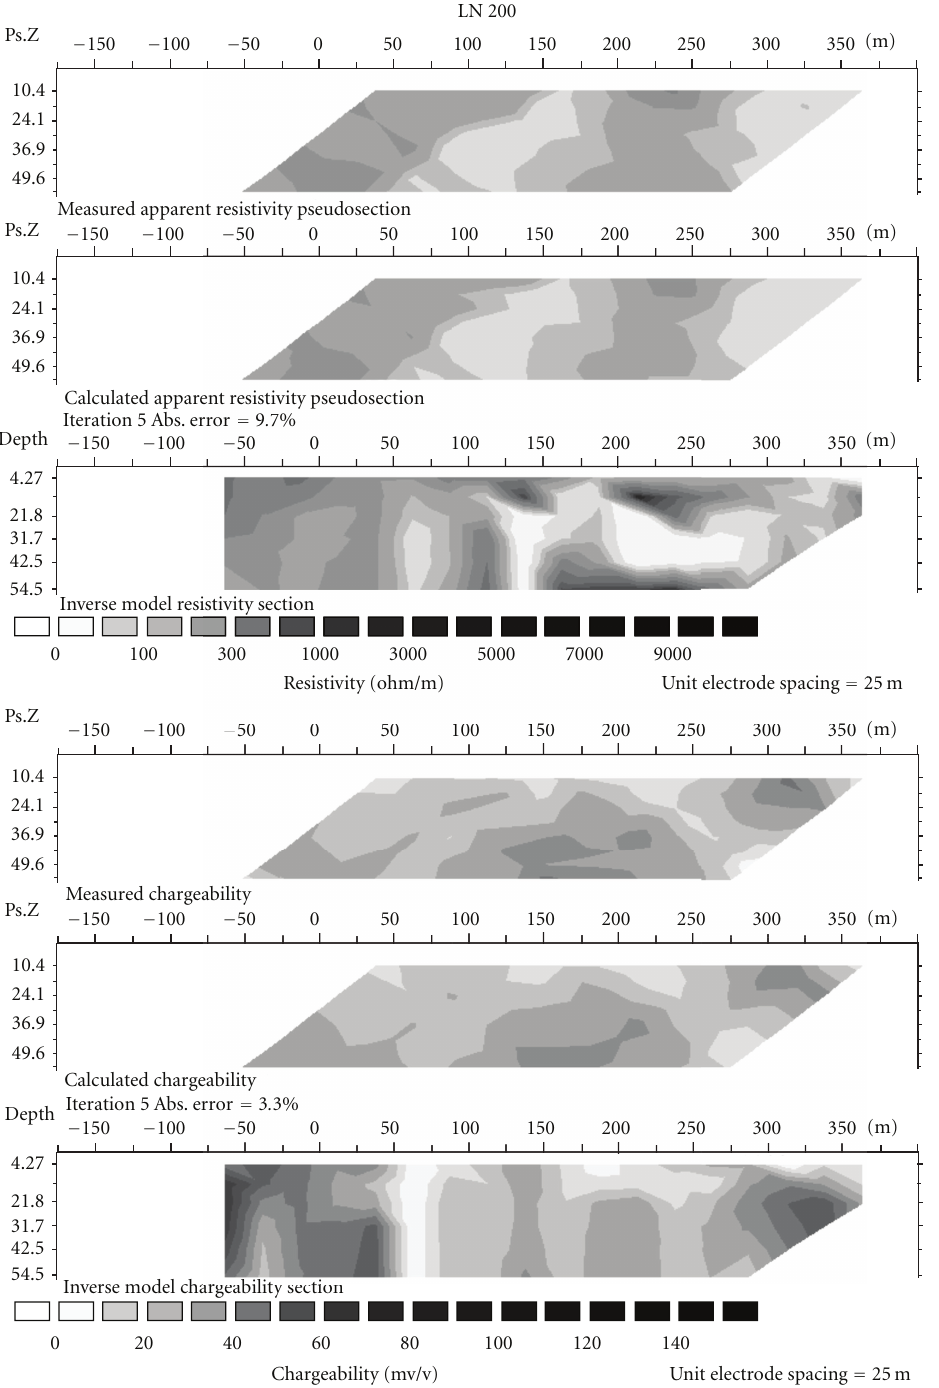
Figure 2: Measured and calculated apparent pseudosections and inverse models sections of resistivity and chargeability for no. 200 La Nueva